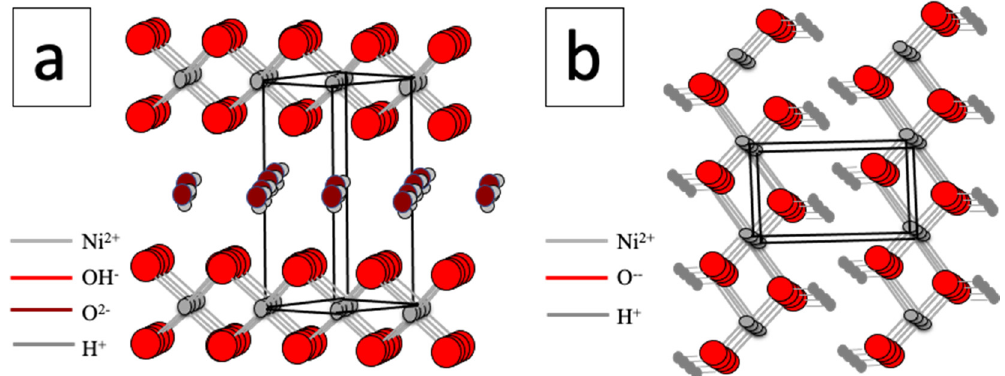
Figure 2: The structure of α - Ni ( OH ) 2 ( a ) and β - Ni ( OH ) 2 ( b )